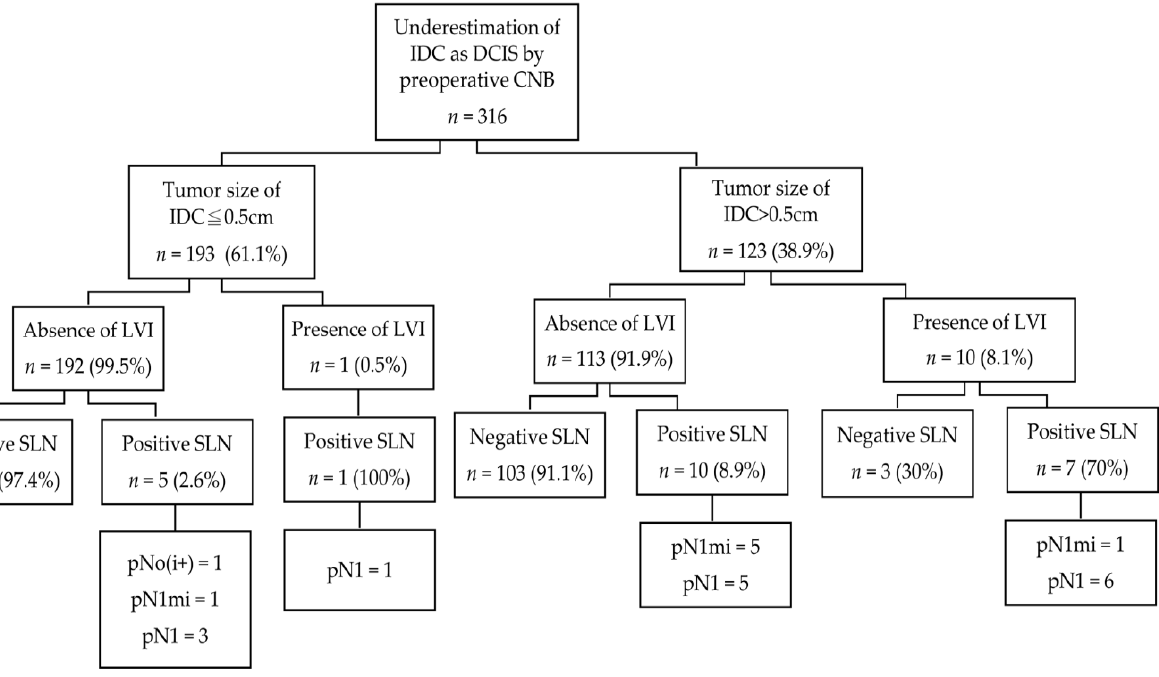
Figure 2. Results of sentinel lymph node biopsy stratified based on tumor size of invasive ductal carcinoma and lymphovas- cular invasion. IDC, invasive ductal carcinoma; DCIS, ductal carcinoma in situ; CNB, core needle biopsy; LVI, lympho- vascular invasion; SLN, sentinel lymph node; pN0(i+), isolated tumor cells; pN1mi, micrometastasis; pN1, 1–3 macrome- tastasis.